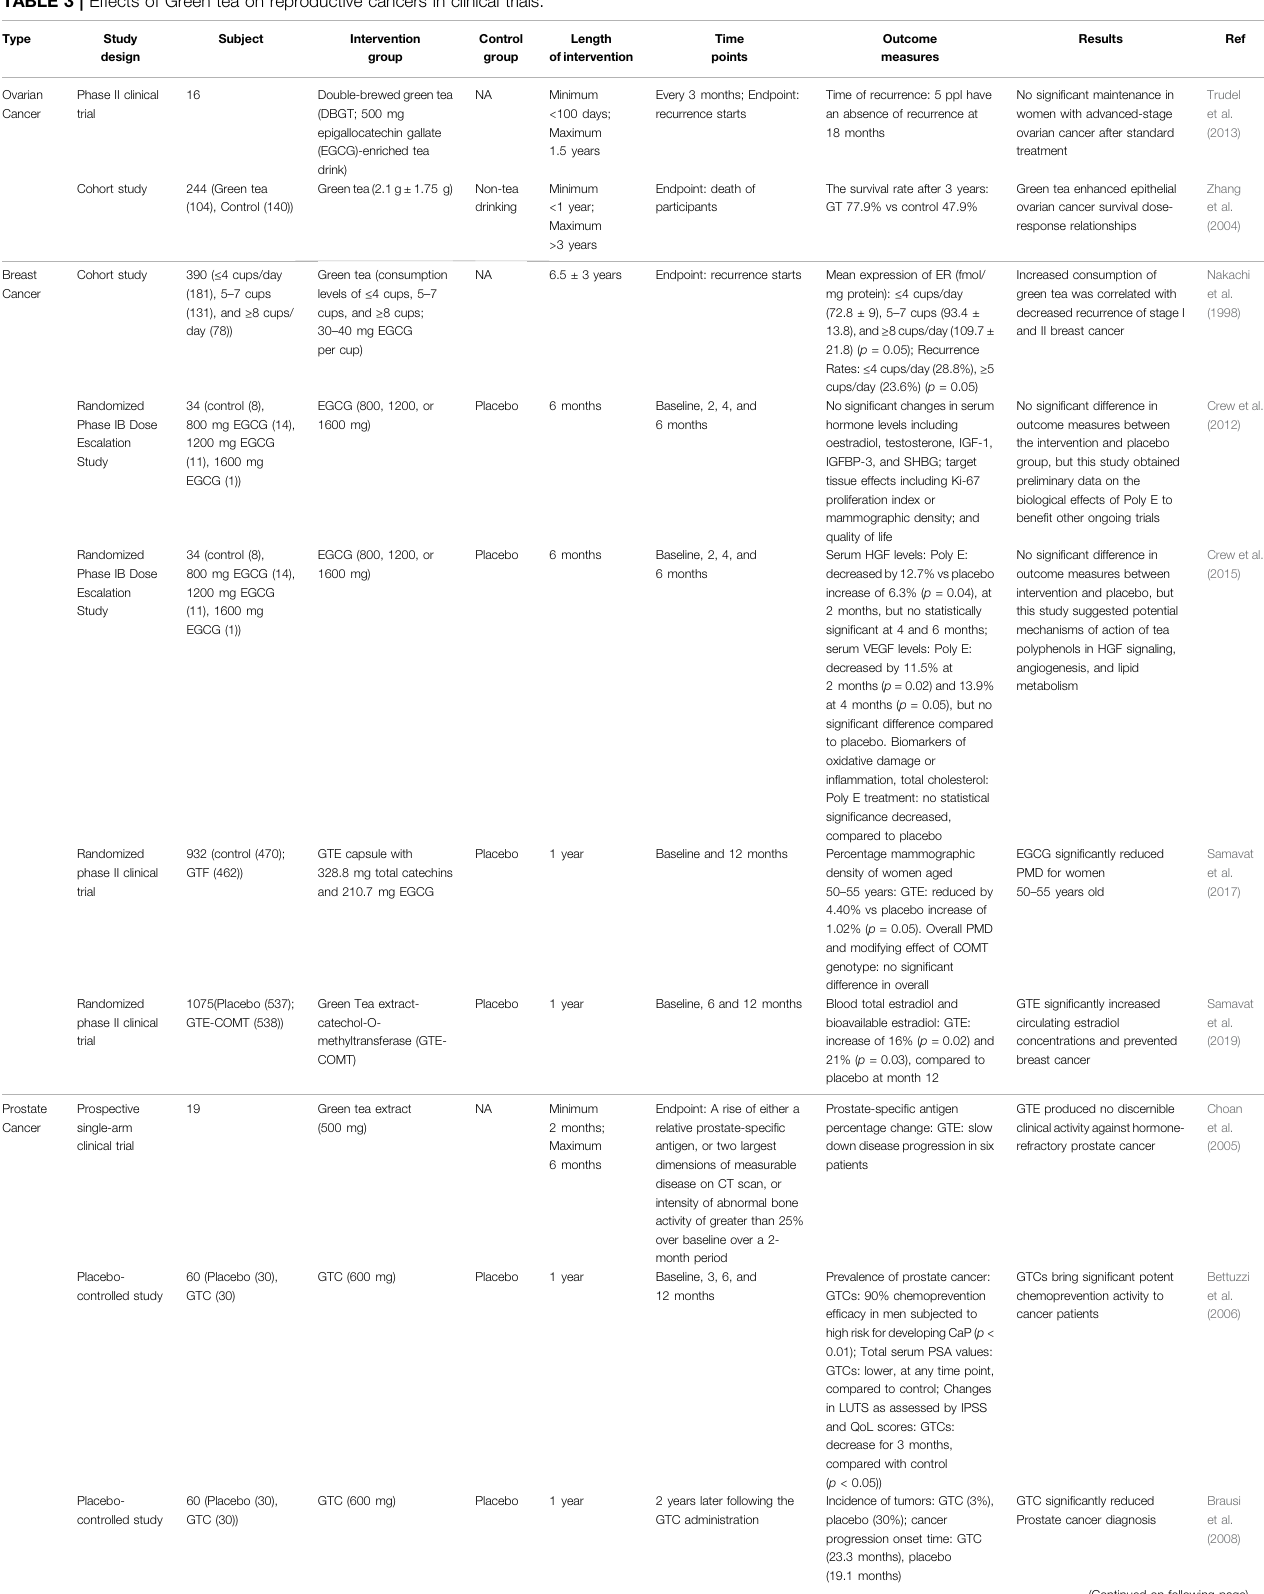
TABLE 3 | Effects of Green tea on reproductive cancers in clinical